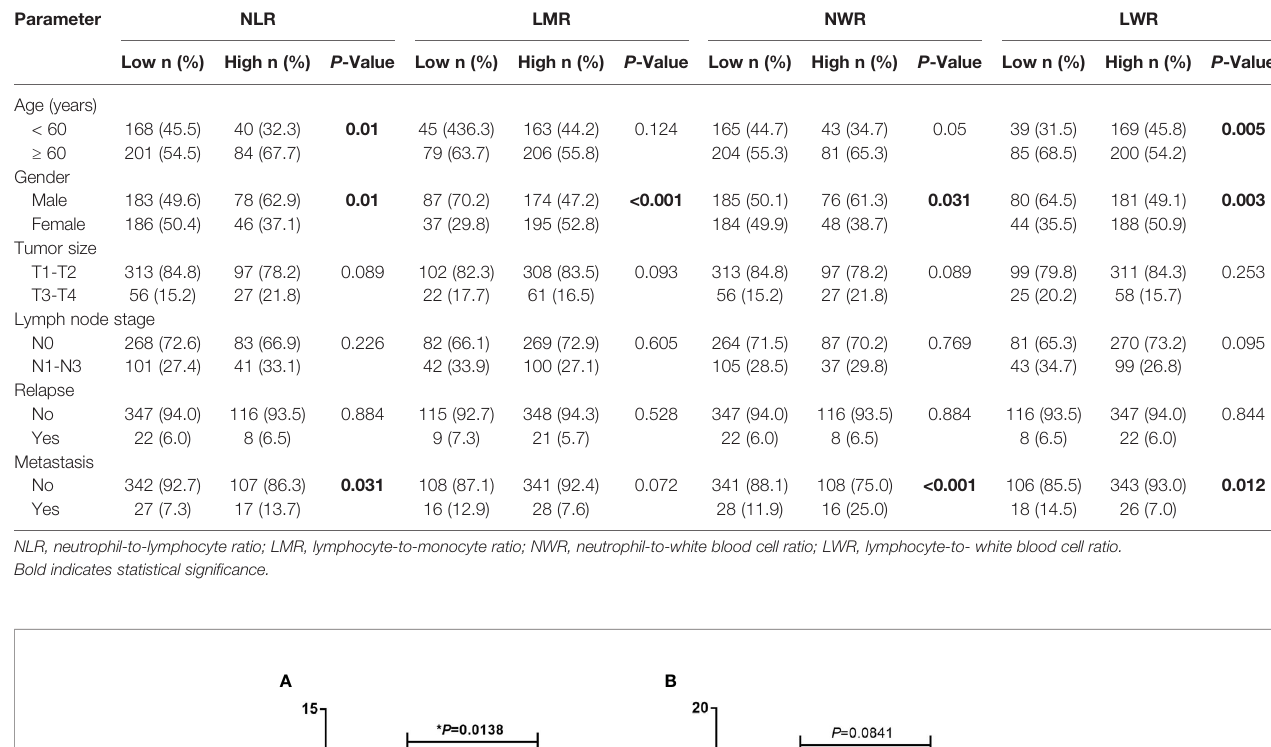
TABLE 2 | Associations of NLR, LMR, NWR, and LWR with clinicopathological characteristics. Parameter NLR LMR NWR LWR